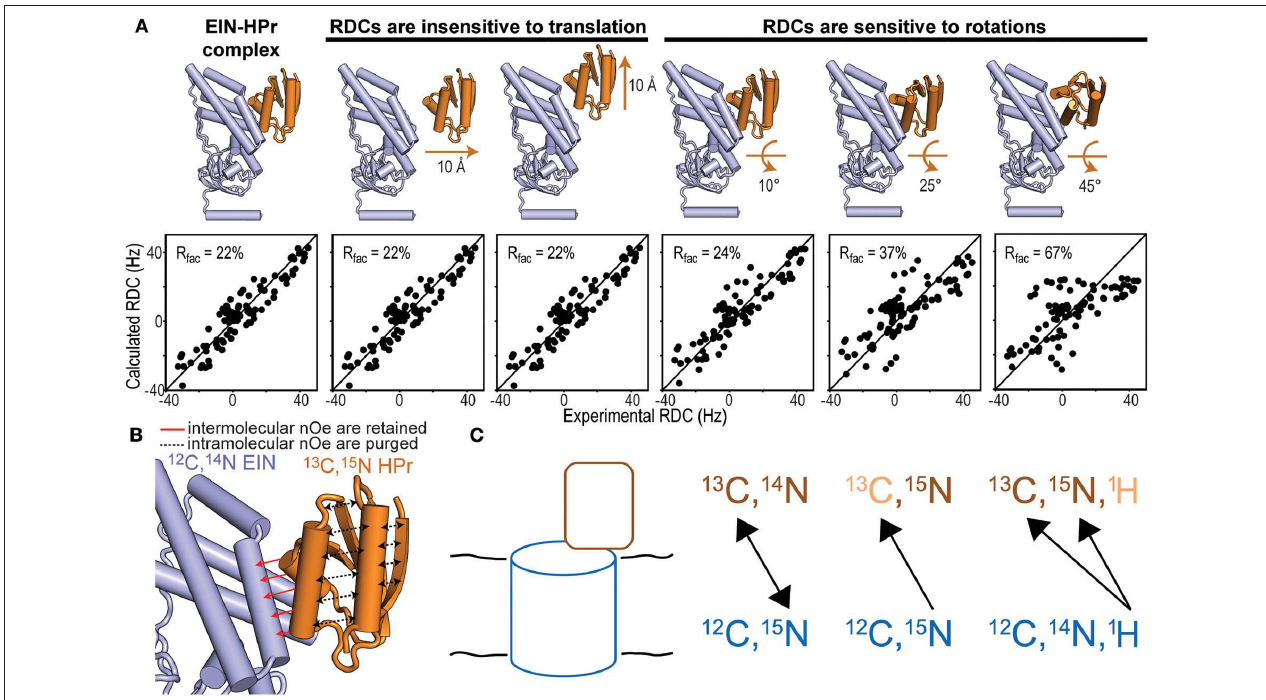
FIGURE 2 | NMR methods for structure determination of macromolecular complexes. (A) Fitting of the experimental N-H N RDCs measured for the phosphorylated EIN-HPr complex (Suh et al., 2008) to (i) the experimental NMR structure (PDB code: 3EZA; left panel), (ii) two structural models generated by 10 Å translation of HPr along two perpendicular directions (seconds and third panels from left), and (iii) three structural models generated by rotations of 10 ◦ , 25 ◦ , and 45 ◦ of HPr about an axis perpendicular to the complex interface (last three panels from left). The quality of the fit is judged in terms of R-factor. A high R-factor indicates poor agreement between the experimental RDC data and the structural model ( Clore and Garrett, 1999). (B) In an isotope-edited/isotope-filtered experiment intramolecular NOEs (black dashed lines) are purged, while intermolecular NOEs (red solid lines) are retained. In panels (A,B) HPr is orange and EIN is blue. (C) Schematic representation of a solid protein complex and heteronuclear polarization transfer schemes. In the first scheme, mixtures of isotopic labeling allow intermolecular heteronuclear correlations. In the seconds scheme, intramolecular 15 N- 13 C dephasing precedes intermolecular heteronuclear 15 N- 13 C correlations. In the third scheme, intramolecular 1 H 11 H- 13 C 33 C/ 15 N 55 N dephasing facilitates intermolecular 1 H- 13 C/ 15 N cross-polarization that identifies isotopically labeled sites on a protein interacting with an unlabeled binding